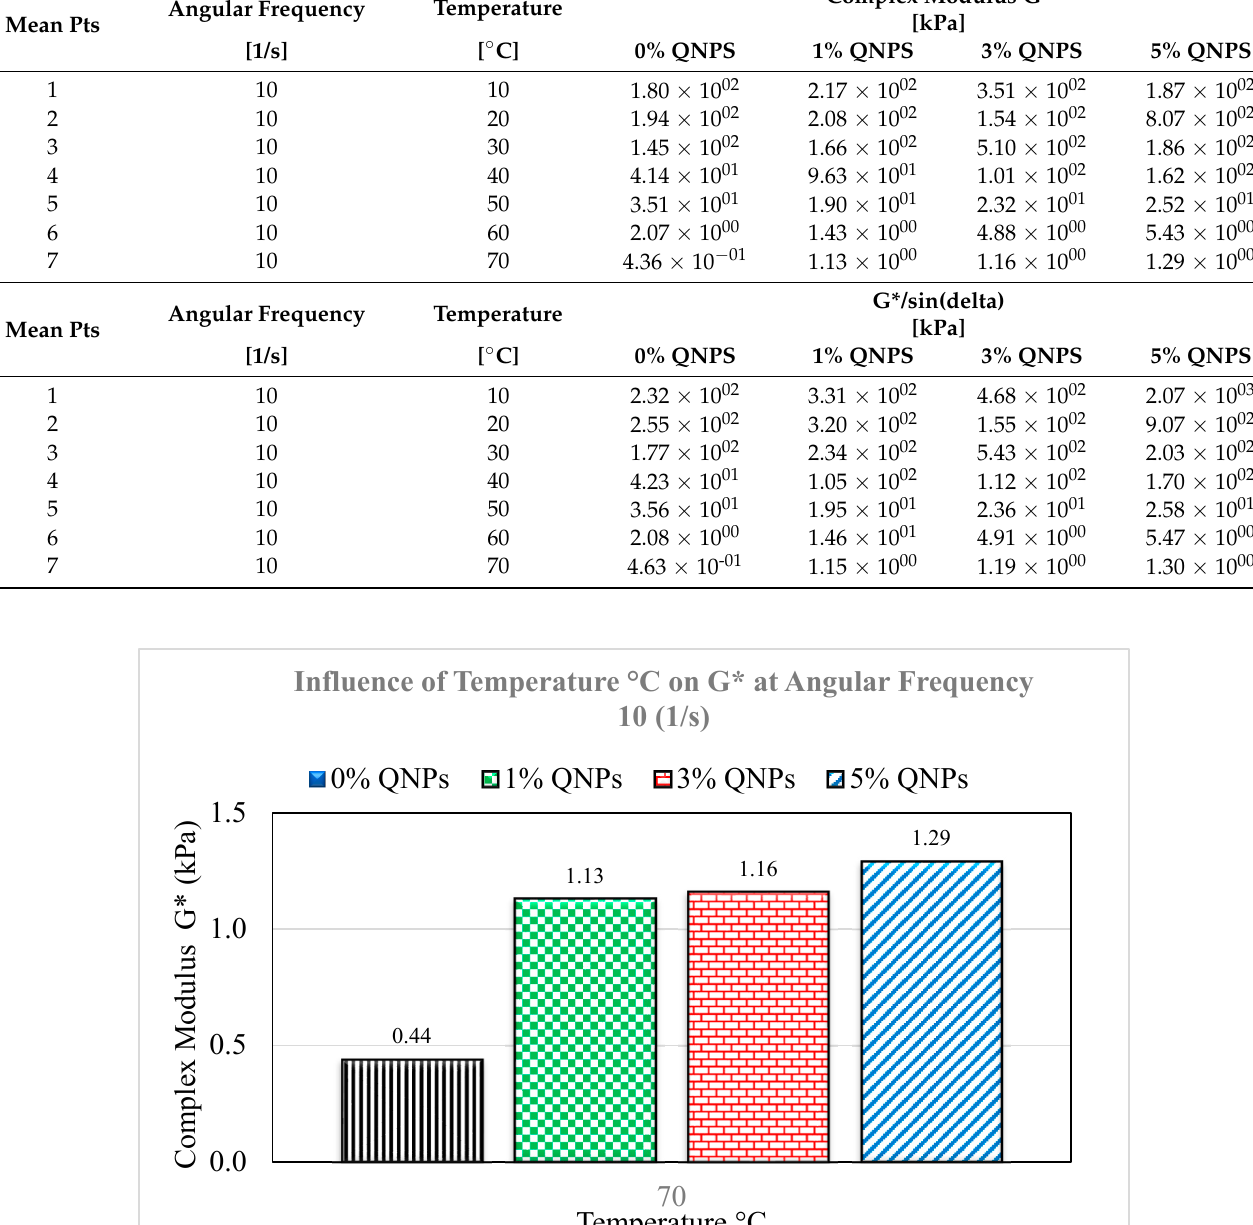
Figure 14. Influence of temperature on G*/Sin ( δ ).